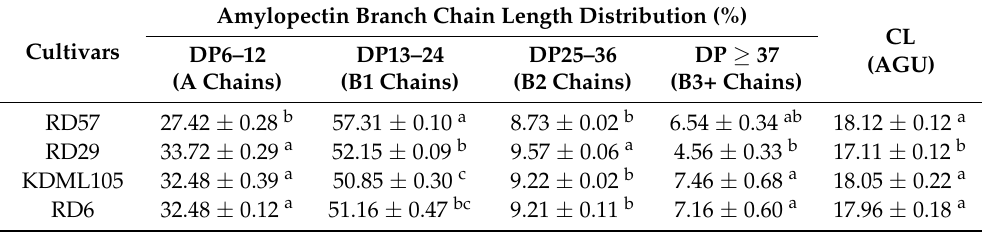
Table 2. The amylopectin fine structure of four Thai commercial rice starches with different pasting properties.